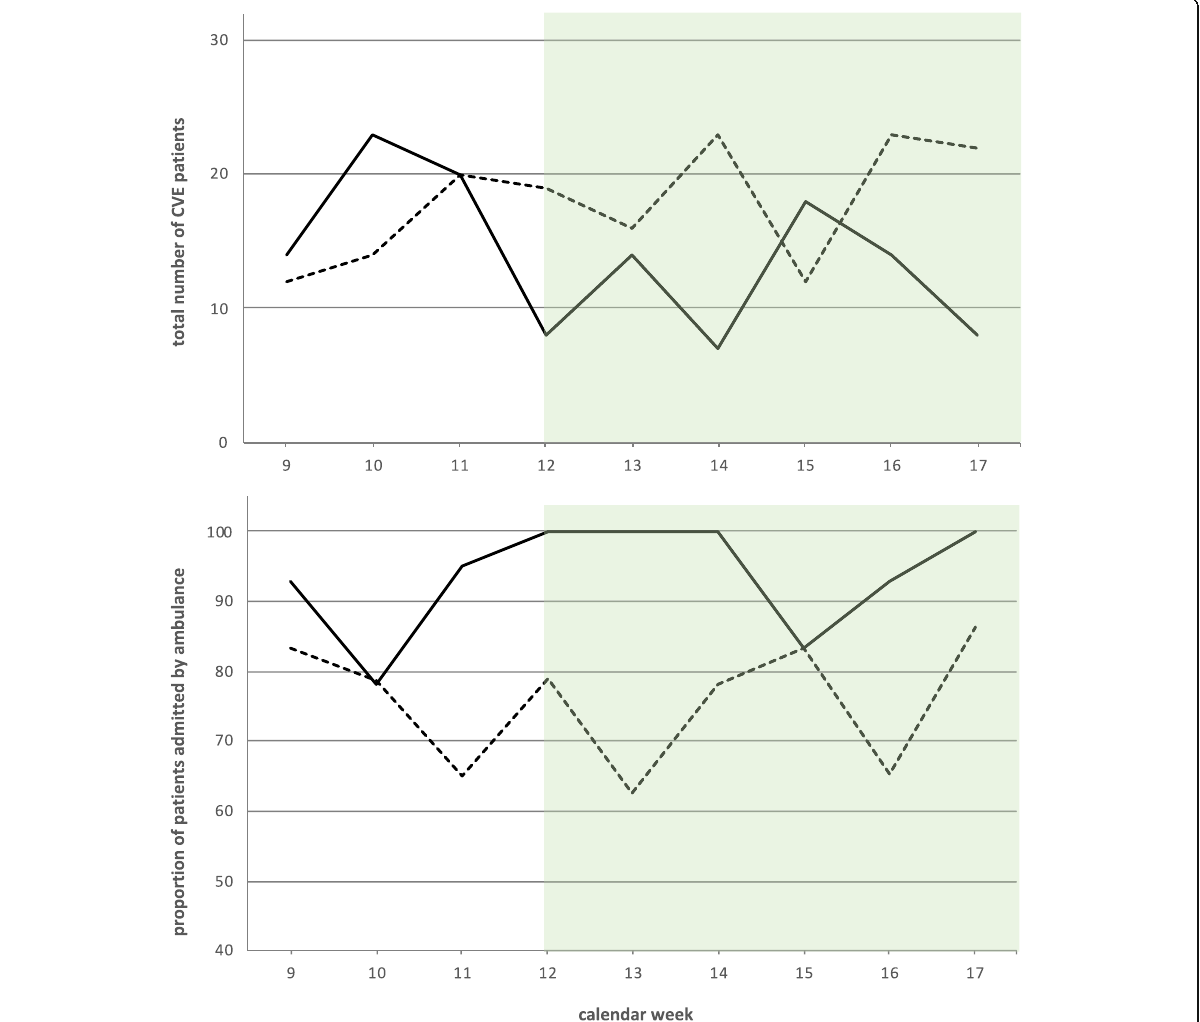
Fig. 1 Admissions due to a CVE and arrival via ambulance during weeks 9-17 in years 2019 and 2020. CVE admissions decreased by 35.9% (upper panel) and admissions via ambulance increased by 18.5% (lower panel) during the COVID epoch in 2020. Pale green: COVID epoch. Dotted line: year 2019, solid line: year 2020. CVE = cerebrovascular